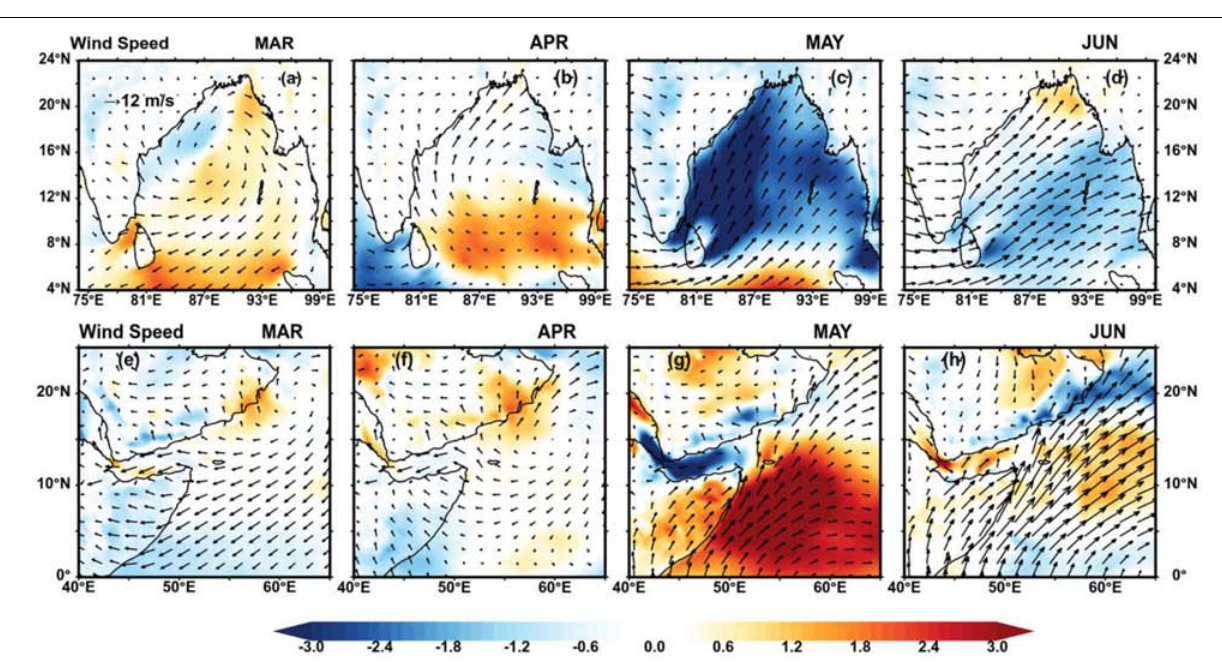
(ESA-OC-CCI). 2 The Chl-a concentration daily data